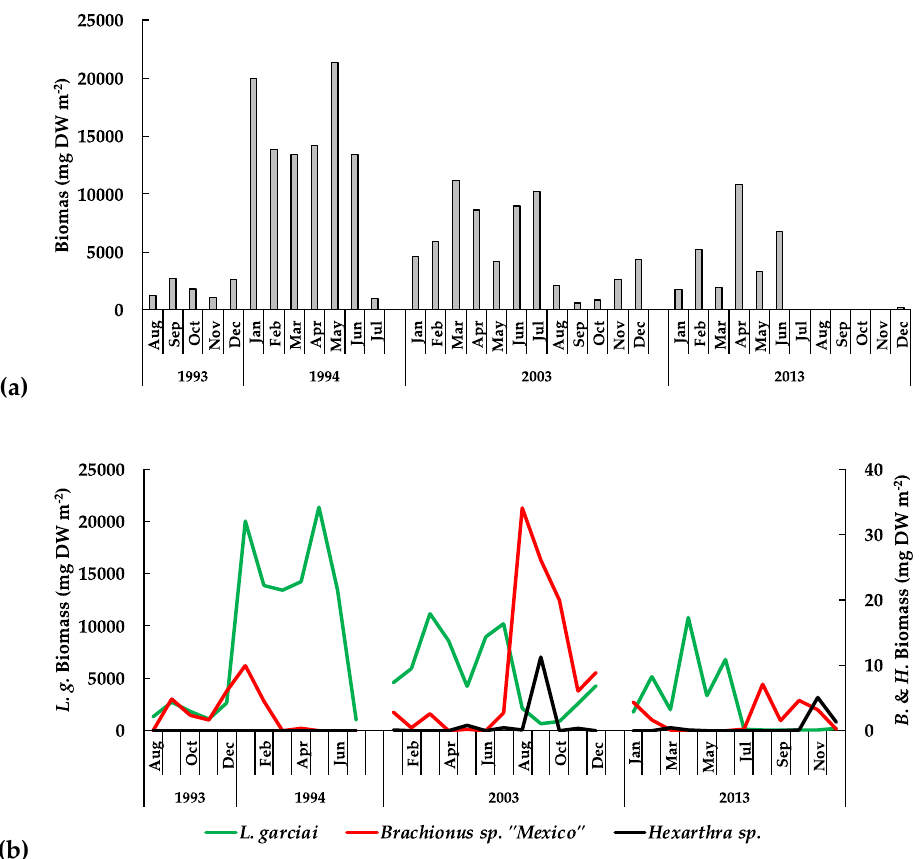
Figure 14. Temporal dynamics of the ( a ) total zooplankton and ( b ) per species biomass in Lake Alchichica during 1993–1994, 2003, and 2013. (DW: dry weight). ( L.g. = Leptodiaptomus garciai , B . = Brachionus sp. “Mexico”, H . = Hexarthra sp.).